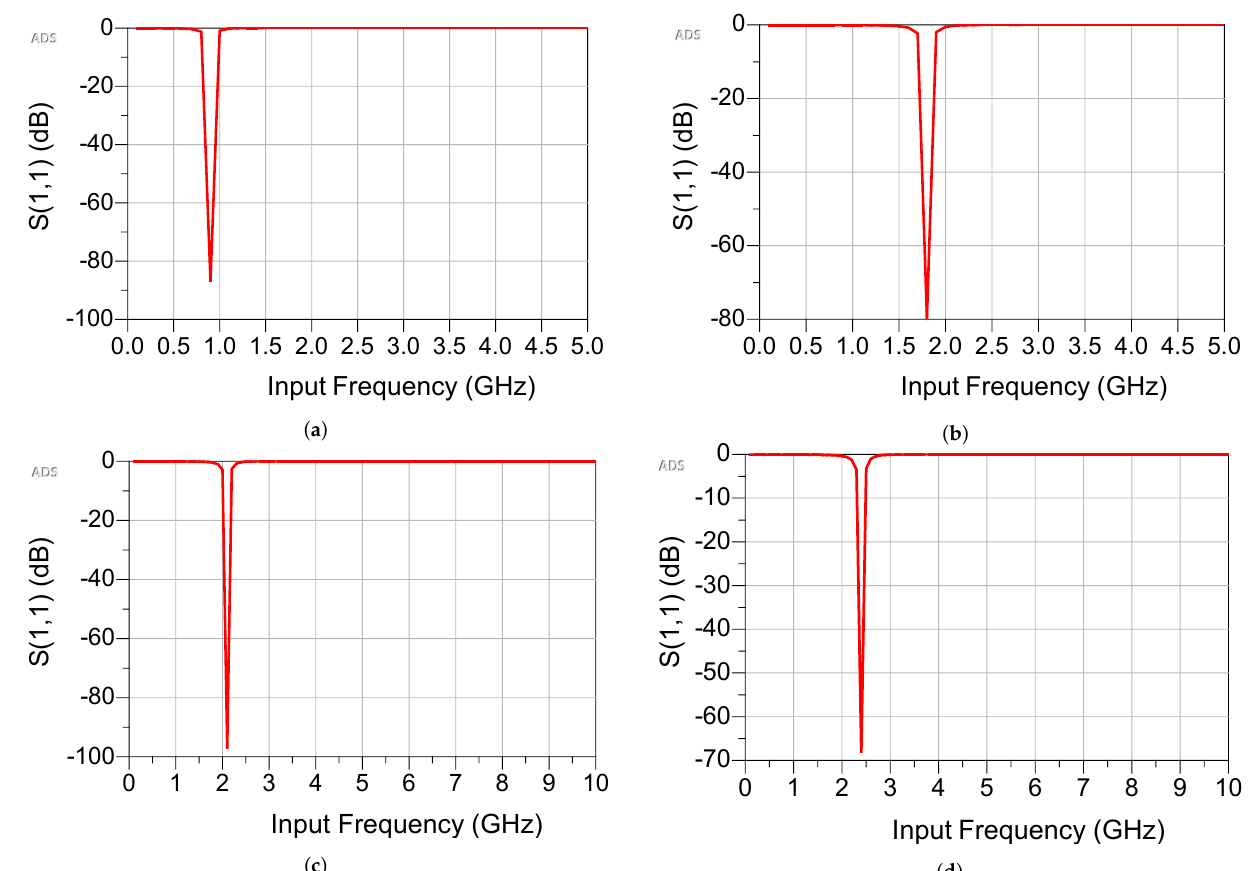
Figure 10. S-parameters for each single-band. ( a ) GSM-900. ( b ) GSM-1800. ( c ) UMTS-2100. ( d ) Wi-Fi 2.45. where P out is the harvested DC power across the load resistor. From Figure 11, maximum efficiencies of 82.345% at 6 dBm, 78.165% at 8 dBm, 75.72% at 8 dBm, and 74.622% at 9 dBm were obtained for the GSM-900, GSM-1800, UMTS-2100, and Wi-Fi 2.45 bands, respectively. The output voltage was 1.489 V, 1.276 V, 1.22 V, and 1.163 V, respectively, for the mentioned bands at 0 dBm. The highest output voltage obtained at 20 dBm for the Wi-Fi 2.45 band was 3.579.